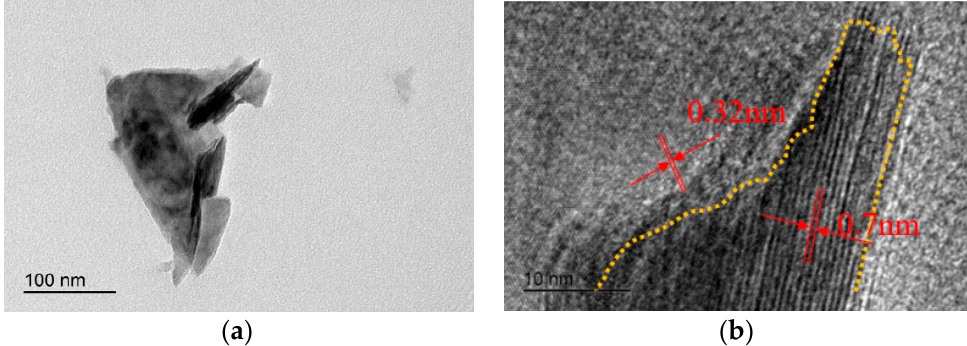
Figure 3. SEM pictures and energy-dispersive spectroscopy (EDS) analyses of ( a , c ) WS 2 , and ( b , d ) WS 2 -C. Figure 4. Micro-morphology of WS 2 -C nano-sheets from ( a ) TEM, and ( b ) high-resolution TEM (HRTEM).